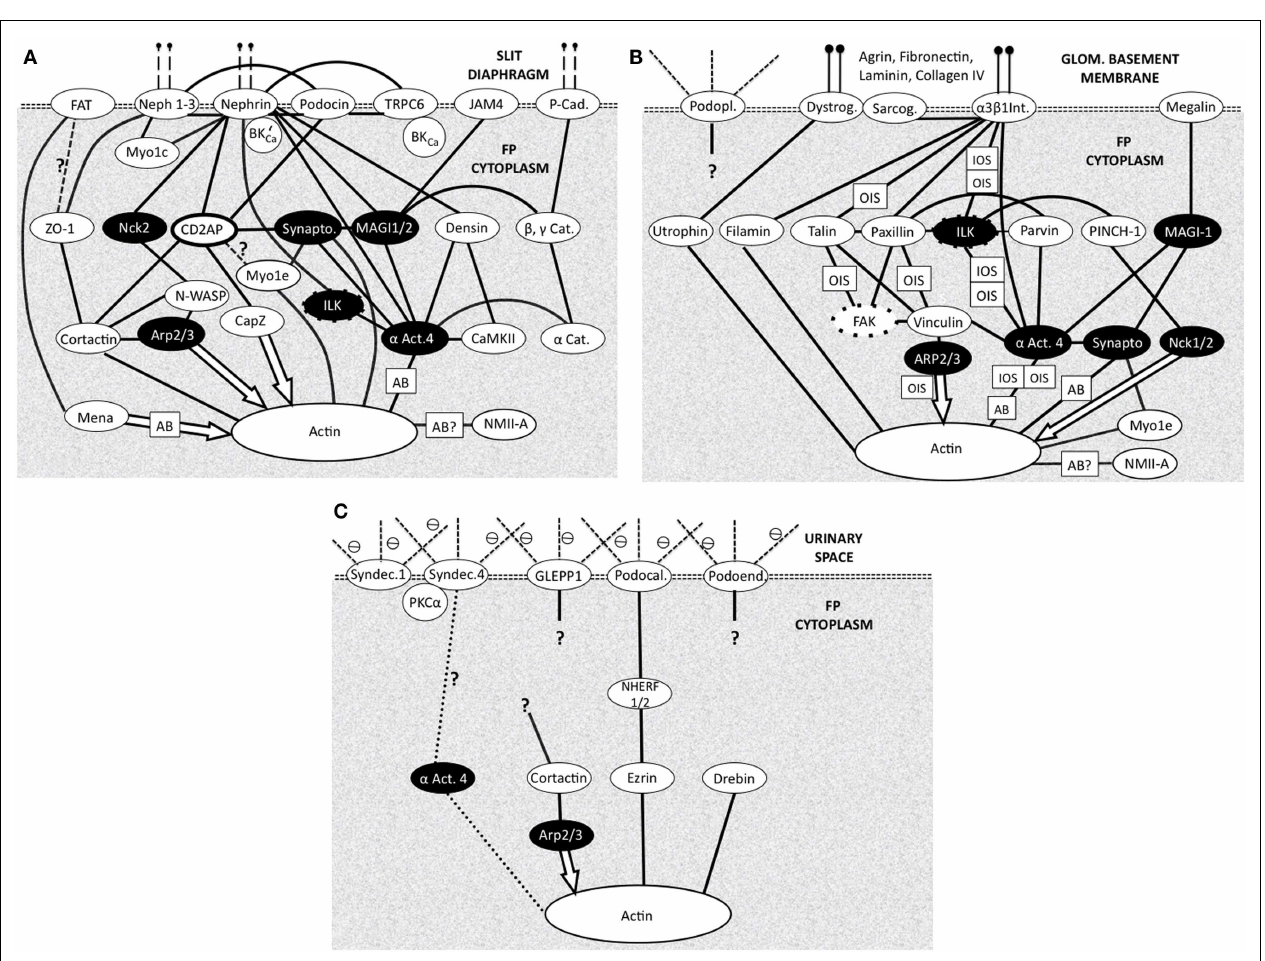
FIGURE 3 | Foot process membrane and associated domains with membrane proteins at the top then adapter and effector proteins leading to actin . Each domain is connected to the underlying cortical actin network and to the other domains. (N.B. Not all protein interactions are shown) all are bidirectional biochemical interactions except effector molecule interactions (arrows). Question marks show uncertainty.White text on black shows common adapter/effector molecules across the three domains. Most actin interactions will be with local cortical actin with some potential longer range actin bundle interactions (AB) Figure adapted from Refs. (13, 38, 39) . (A) Slit diaphragm domain (SDD).Vertical dashed lines at the top indicate